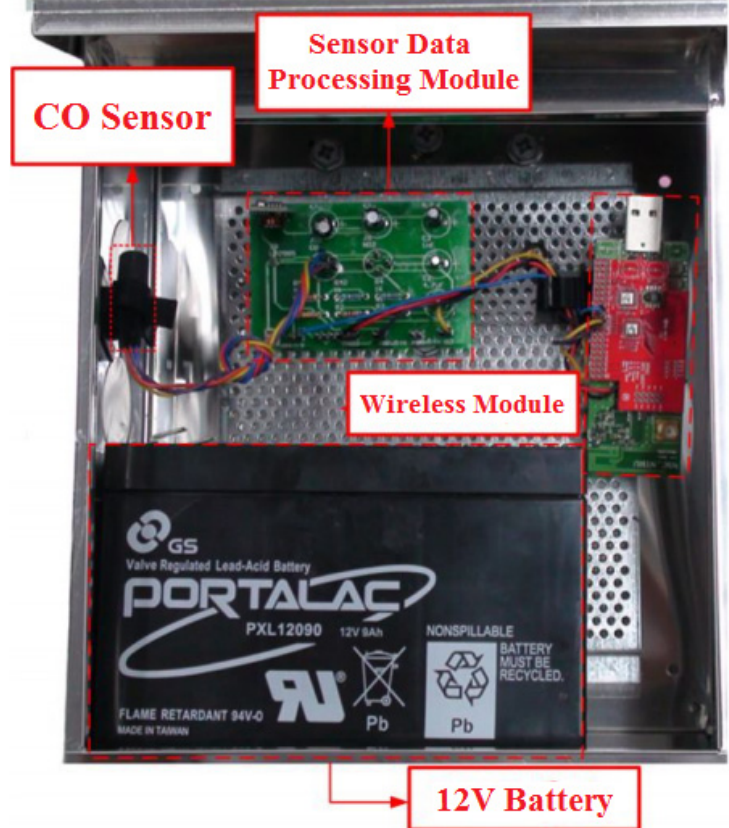
Figure 3. Instruments: A sensor node includes a semi-conductor carbon monoxide sensor, a sensor data processing module and a wireless module. The semi-conductor sensor is used to measure the concentration of air pollutants with variations of voltage. The processing module transfer the voltages gathered by the CO sensor to the CO